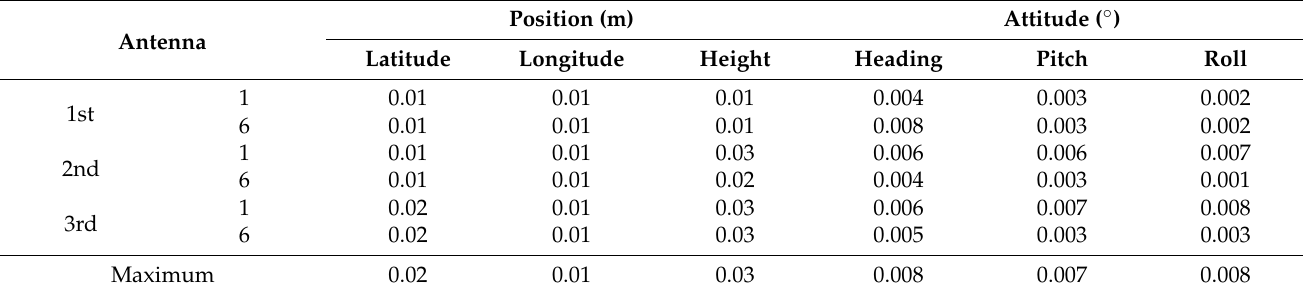
Table 4. Error statistical results of multi-antenna motion.